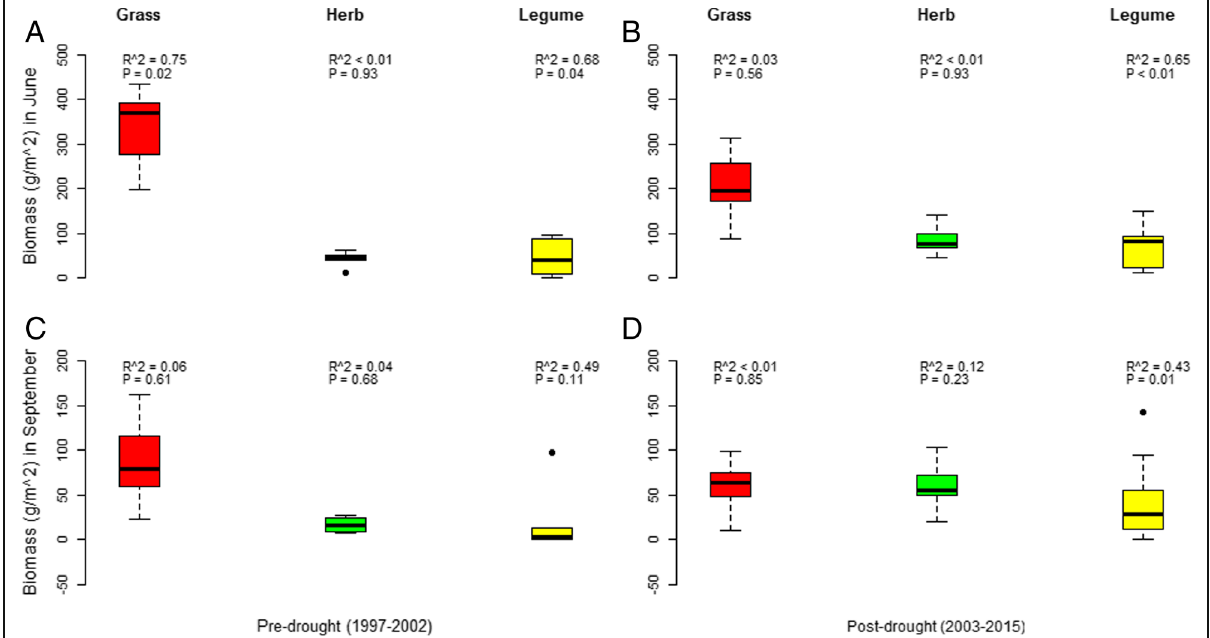
Fig. 7 Functional group aboveground biomass productivity in pre-drought and post-drought. Pre-drought ( a ) and post-drought ( b ) biomass in June; pre-drought ( c ) and post-drought ( d ) biomass in